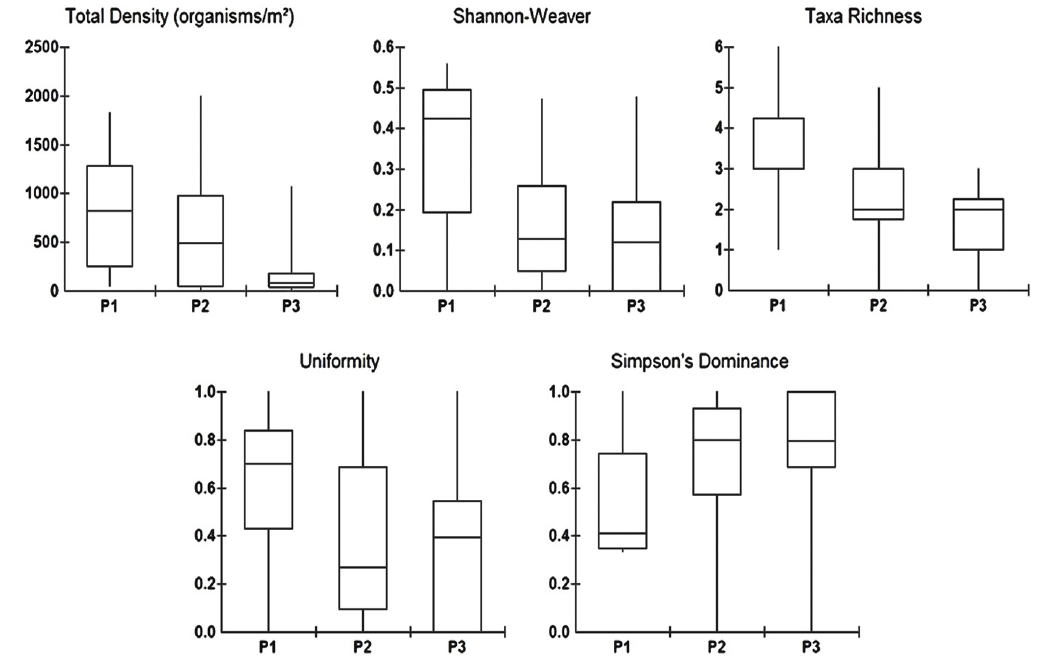
Figure 5. Biotic indices by sampling site (P1 - Taquacetuba, P2 - Alvarenga and P3 - Biguás Island) in Billings Reservoir (Brazil, São Paulo State), represented by box-and-whiskers plots, where the lower and upper limits of the box correspond to the 25th and 75th percentiles, respectively, the whiskers correspond to the minimum and maximum, and the center line of distribution corresponds to the